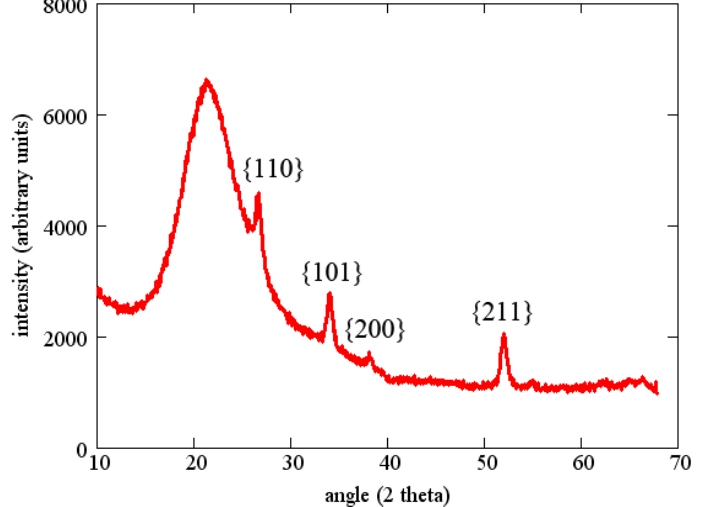
layer after annealling. 2